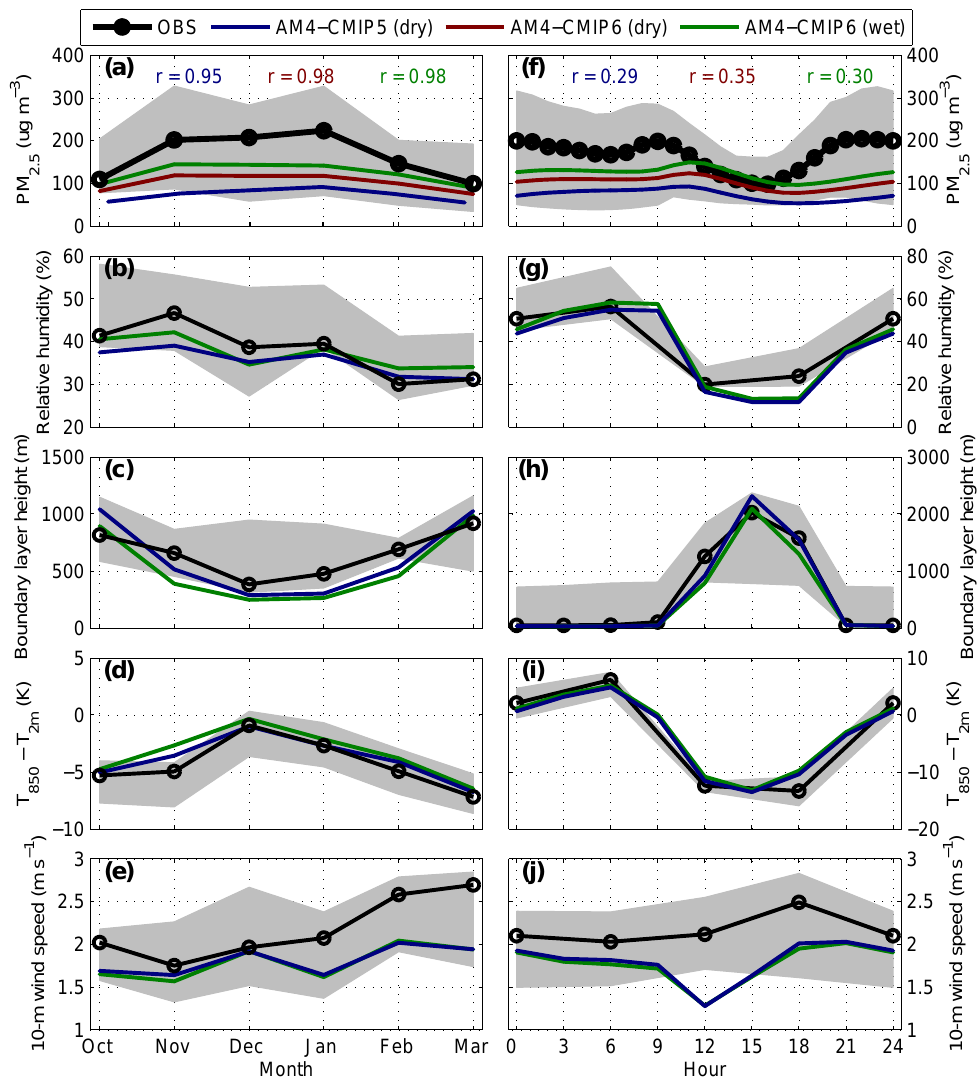
Figure 6. (a–e) Monthly (October–March) and (f–j) diurnal cycles of (a, f) PM 2 . 5 , (b, g) relative humidity, (c, h) boundary layer height, (d, i) INV, and (e, j) 10m wind speed. The min-to-max range of the observations is shown in gray with the median in black. The median of grid cells containing the sites for the AM4-CMIP5 dry, AM4-CMIP6 dry, and AM4-CMIP6 wet are shown in blue, red, and green, respectively. Model-measurement correlations for the PM 2 . 5 cycles are also